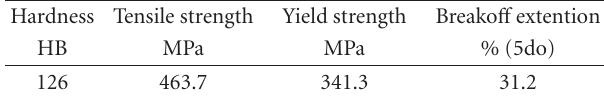
Table 2: Selected mechanical properties of test